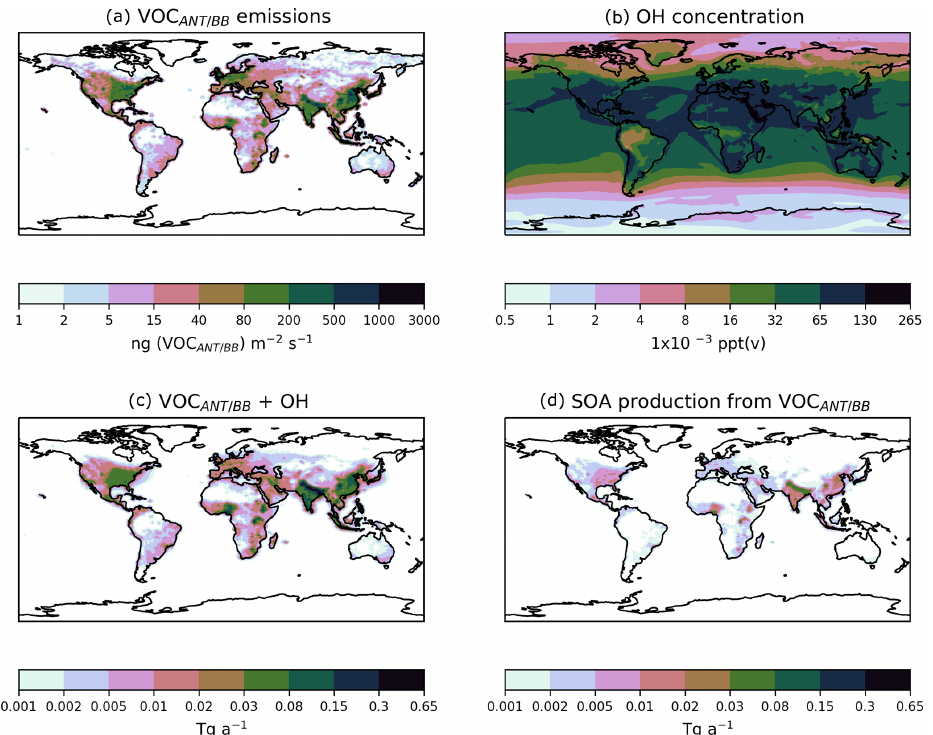
Figure 8. Global distributions of (a) the annual-total VOC ANT / BB emission rate (ng(VOC ANT / BB )m − 2 s − 2 ), (b) the annual mean surface OH concentrations (ppt(v)), (c) the annual-total vertically integrated VOC ANT / BB oxidation rate by OH (Tga − 1 ), and (d) the corresponding annual-total SOA production rate (Tga − 1 ), when SOA precursor deposition and a single oxidation step with a yield of 13% is applied (DryH_WetL; Table